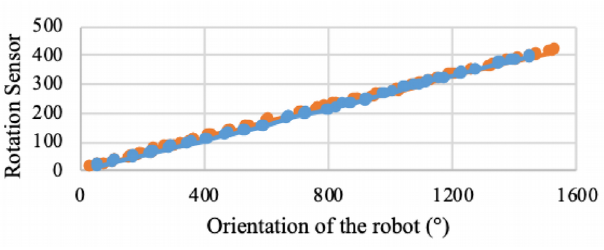
Figure 3. Rotation sensors vs. Orientation of the